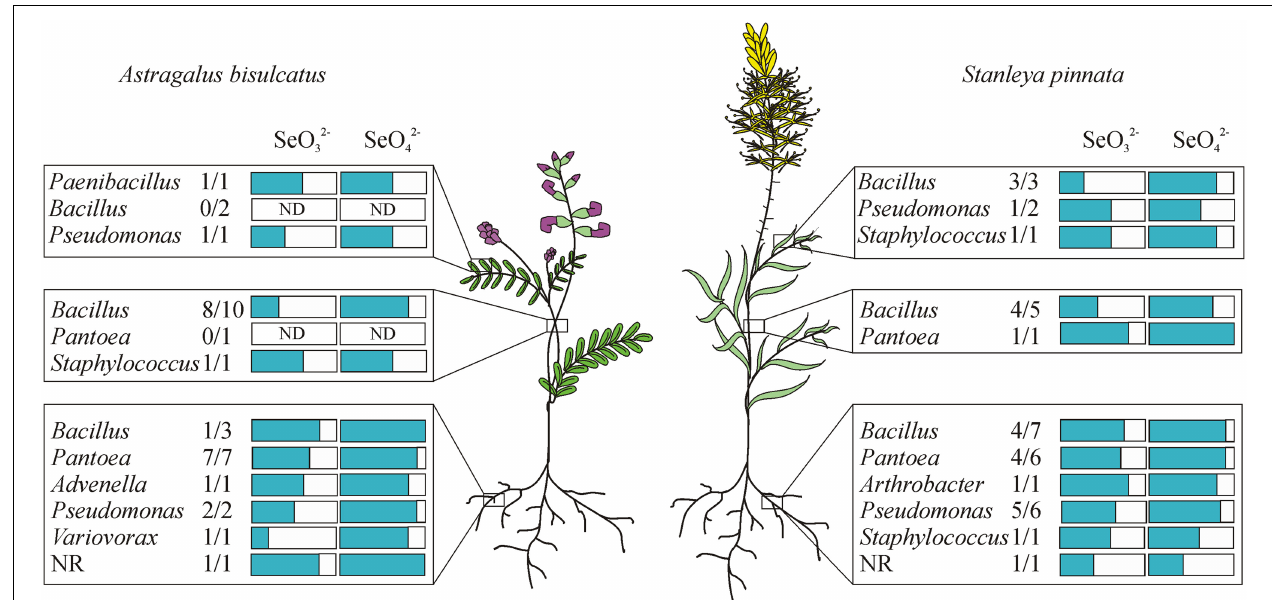
FIGURE 5 | Distribution of endophytic bacterial isolates in the hyperaccumulators Astragalus bisulcatus and Stanleya pinnata and their resistance to selenite and selenate (scored from 1 to 5). Plants were collected at the Pineridge Natural Area, a seleniferous site west of Fort Collins, CO,